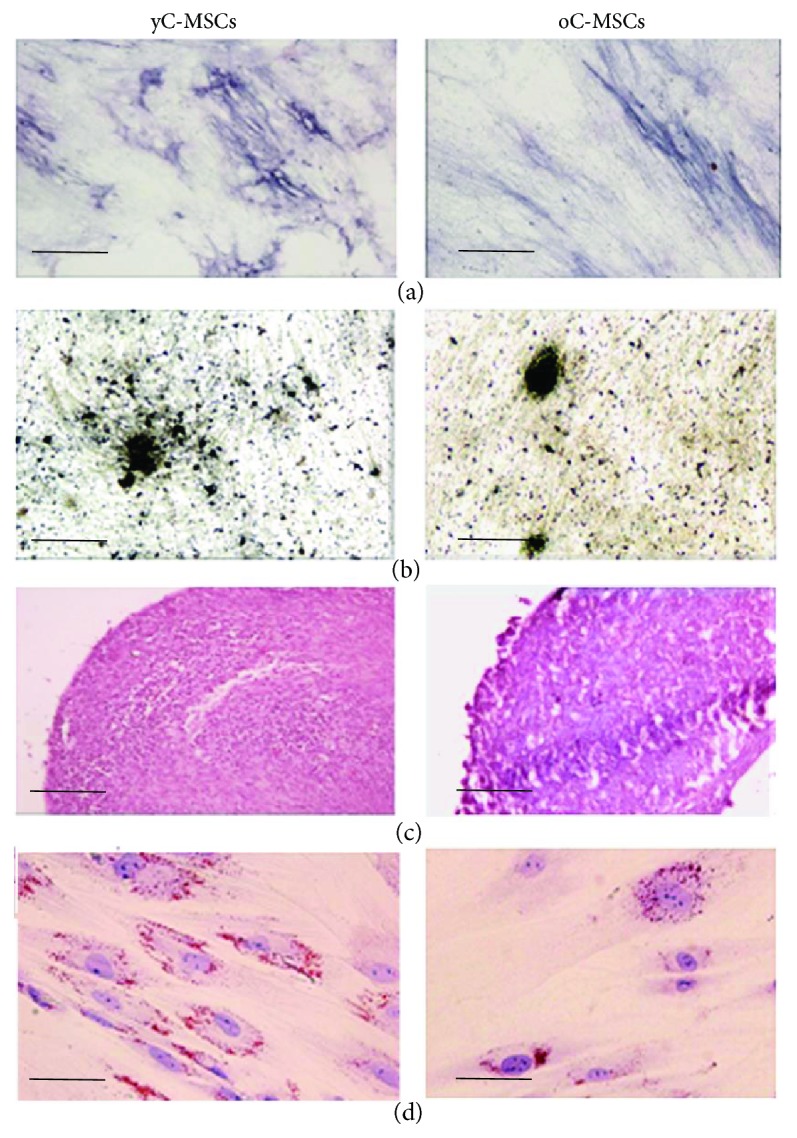
Multilineage differentiation of MSCs derived from younger (yC-MSCs) and older (oC-MSCs) cervixes. Representative images of osteogenic differentiation assessment by ALP reaction (a, scale bar 100 μm) and Von Kossa staining (b, scale bar 100 μm); chondrogenic differentiation by Safranin-O coloration (c, scale bar 200 μm); and adipocyte differentiation by Oil Red staining (d, scale bar 30 μm).